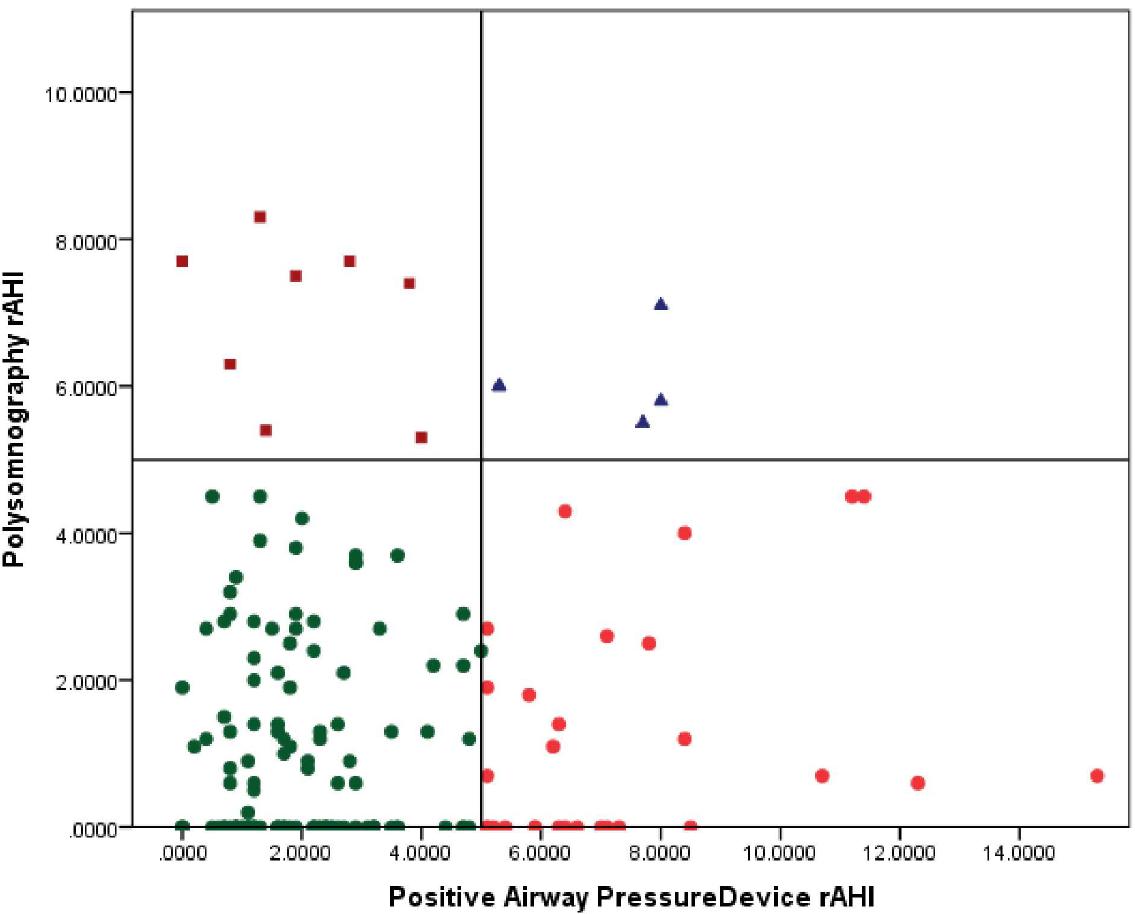
Fig 1. Correlation of apnea–hypopnea indices (AHI) obtained by polysomnography (PSG) and positive airway pressure device (PAP). Green circles represent the category of patients for whom the AHI was (cid:20) 5 both in PSG and using the PAP device (n = 121). Red circles represent the category of patients for whom the PSG titration yieldedan AHI of (cid:20) 5 whereasthe PAP device AHI was > 5 (n = 29). Blue trianglesrepresent the group of patients for whom both the PSG and PAP titration yieldedan AHI of > 5 (n = 5). Maroonsquaresrepresent the category for whom the PSG titration led to AHI > 5 whereas the PAP device AHI was (cid:20) 5 (n = 8).